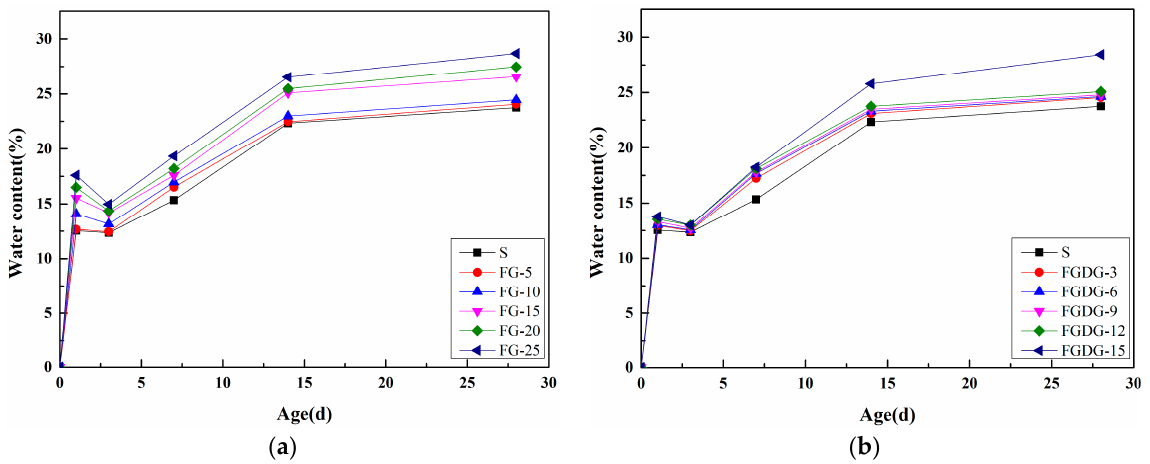
Figure 7. Effect of two types of gypsum on water content results: ( a ) FG; ( b ) FGDG.